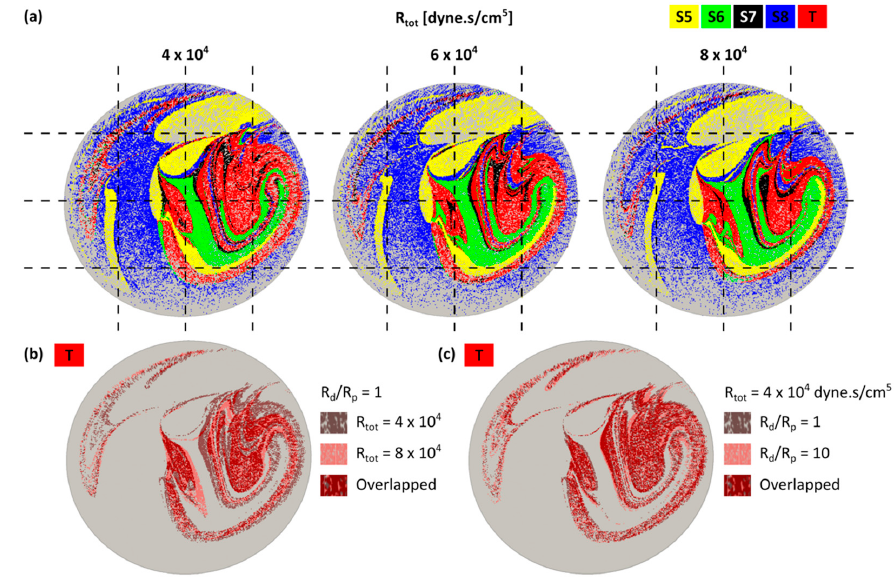
Figure 3. ( a ) Particle release maps (PRMs) at the inlet of the hepatic arterial tree for R tot = 4, 6, 8 × 10 4 dyne · s / cm 5 with R d / R p = 1. Streamlines delivered to the same liver segment are color-coded; ( b ) comparison between the tumor PRMs for R tot = 4 and 8 × 10 4 dyne · s / cm 5 with R d / R p = 1; ( c ) comparison between the tumor PRMs for R d / R p = 1 and 10 ( R tot = 4 × 10 4 dyne · s / cm 5 ). In both ( b ) and ( c ), overlap between the PRMs are shown in dark red.